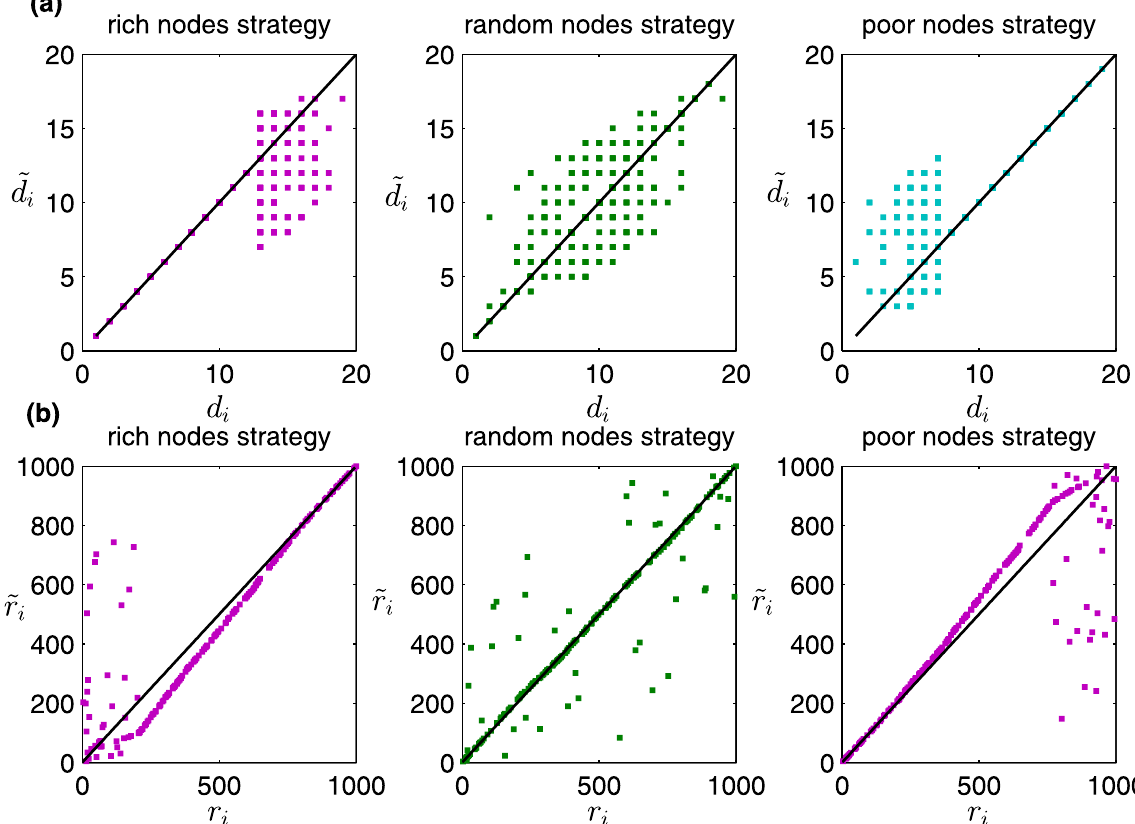
Figure 7. Degrees ( a ) and ranks ( b ) of nodes before and after information disturbance under three typical disturbance strategies. The original network is an ER random graph G N , p , where N = 1000 and q = 0.01. The cost constraint parameter θ is 0.1 and the disturbance range parameter ω is 20%. The solid lines are the reference lines which represent that